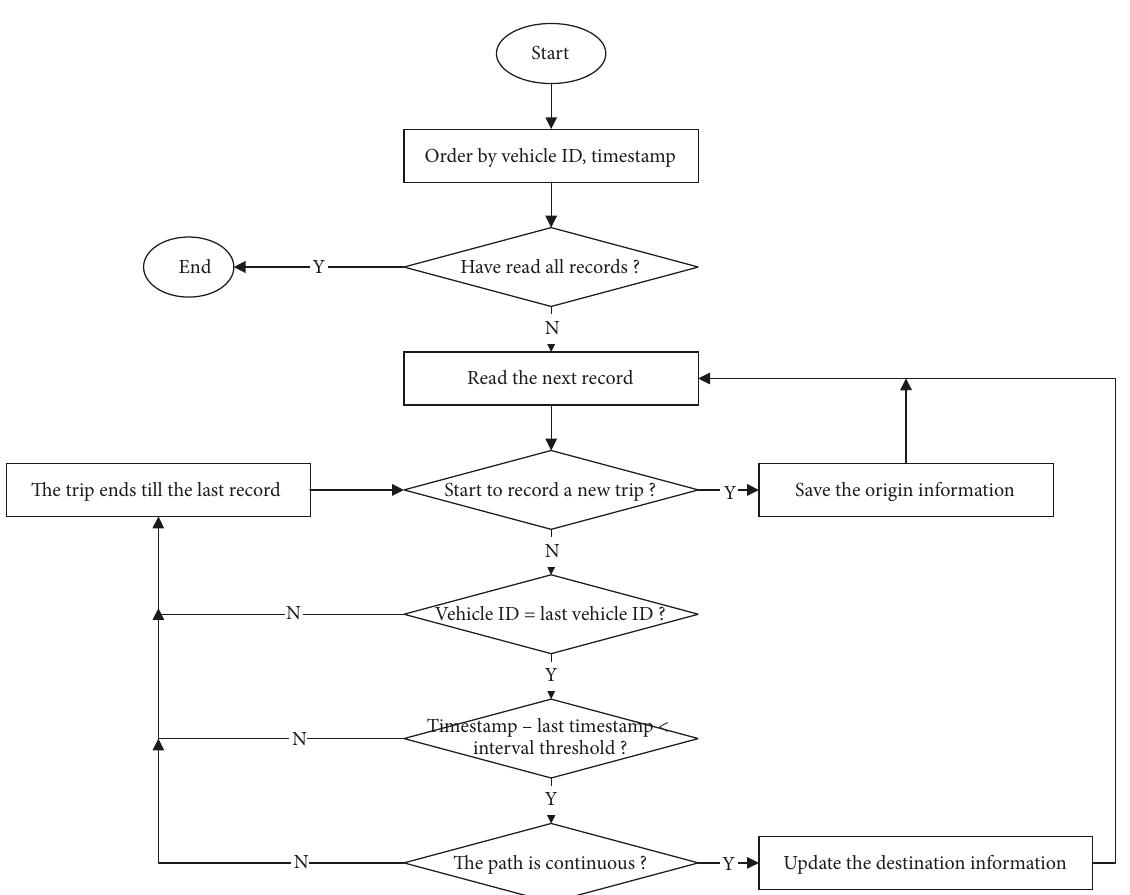
Figure 4: The flow chart of the algorithm to extract origin-destination from trajectory